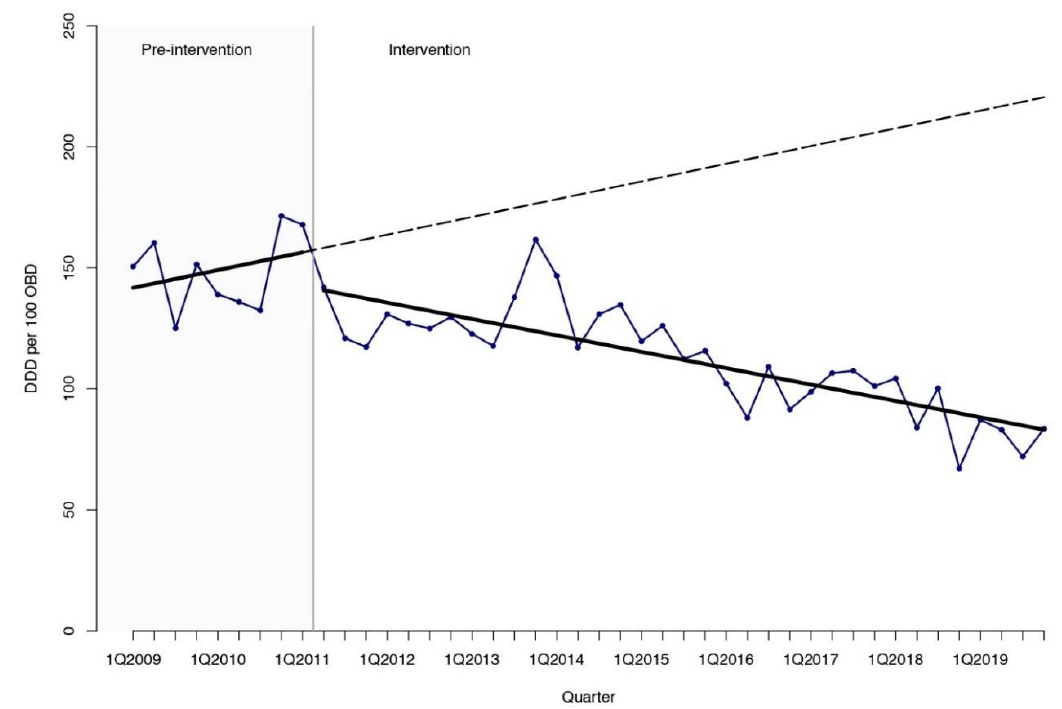
Figure 1. Interrupted time-series analysis of the trends in antimicrobial consumption (antibacterials for systemic use and antifungals) observed before and after the implementation of the antimicrobial stewardship program. Solid lines show the observed trend during the pre-intervention and intervention periods. Dashed lines show the expected trend after the intervention according to the pre-intervention values. DDD, defined daily doses. OBD, occupied bed days. Q,